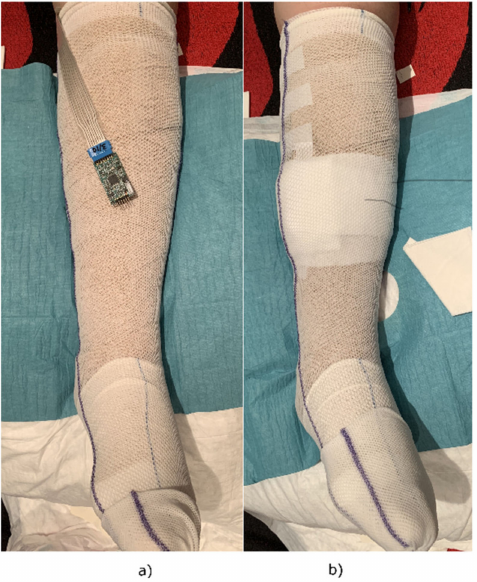
Figure 19. Placement of the system in the wound dressing. ( a ) Sensors applied under a finished bandage; ( b ) protection of the data acquisition system to avoid damaging the device and the patient during their activity.